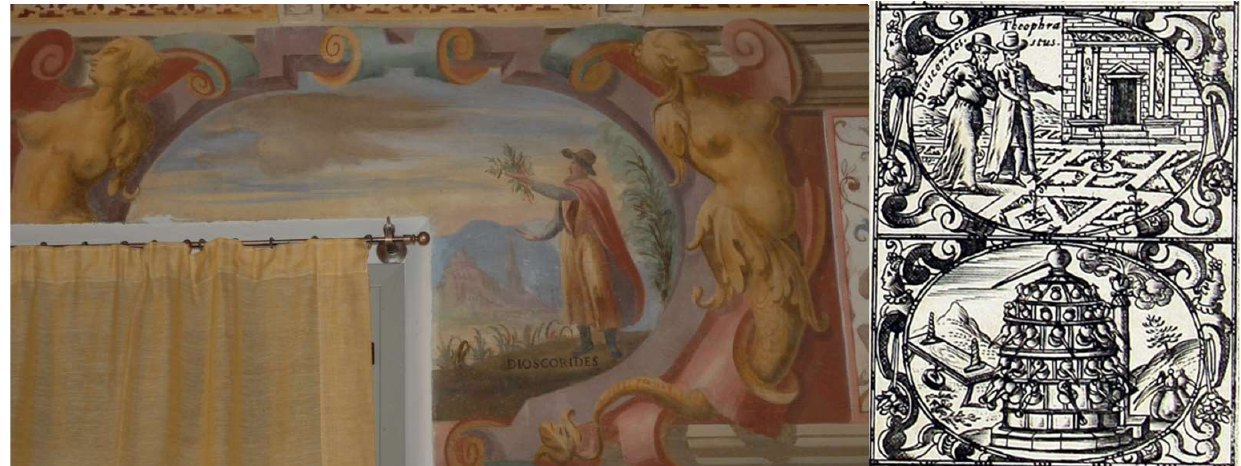
Figure 10. Left : The oval painting shows Dioscorides holding a bunch of freshly picked medicinal herbs. Right : Vignette of Giunti’s edition that can be associated with the oval painting, where Dioscorides is in the company of Theophrastus in a botanical garden.